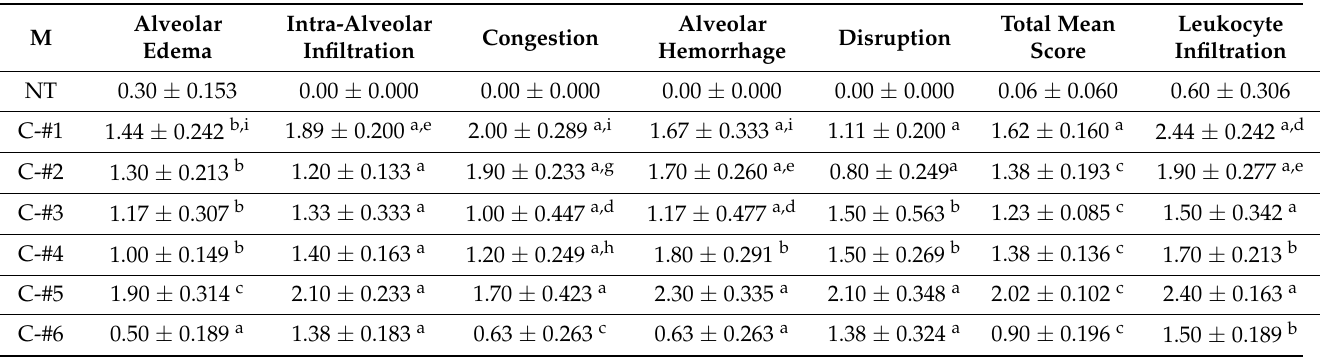
Table 4. Statistics of various indices based on histopathological evaluation of the lungs from male mice.